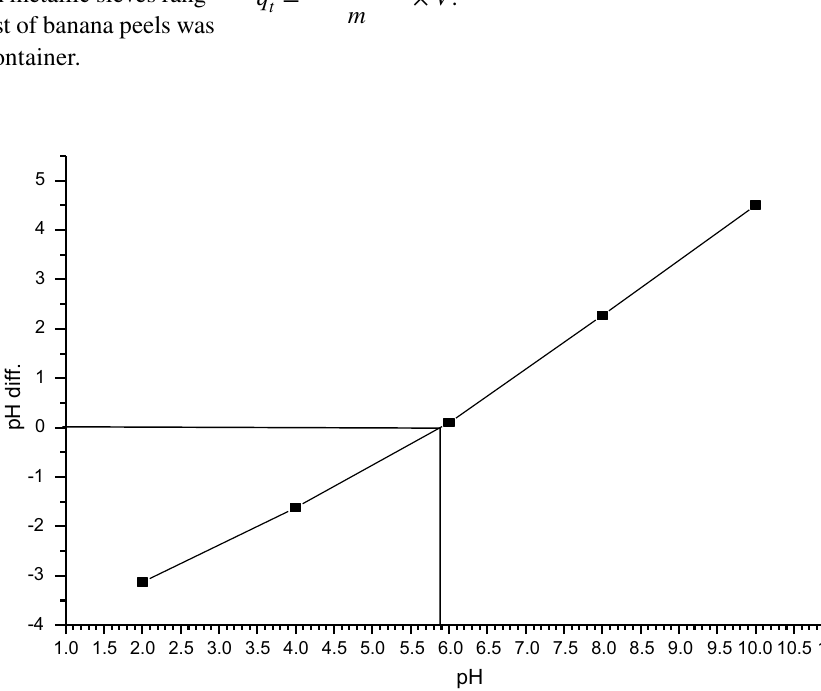
Fig. 1 pH ZPC graph of banana peel